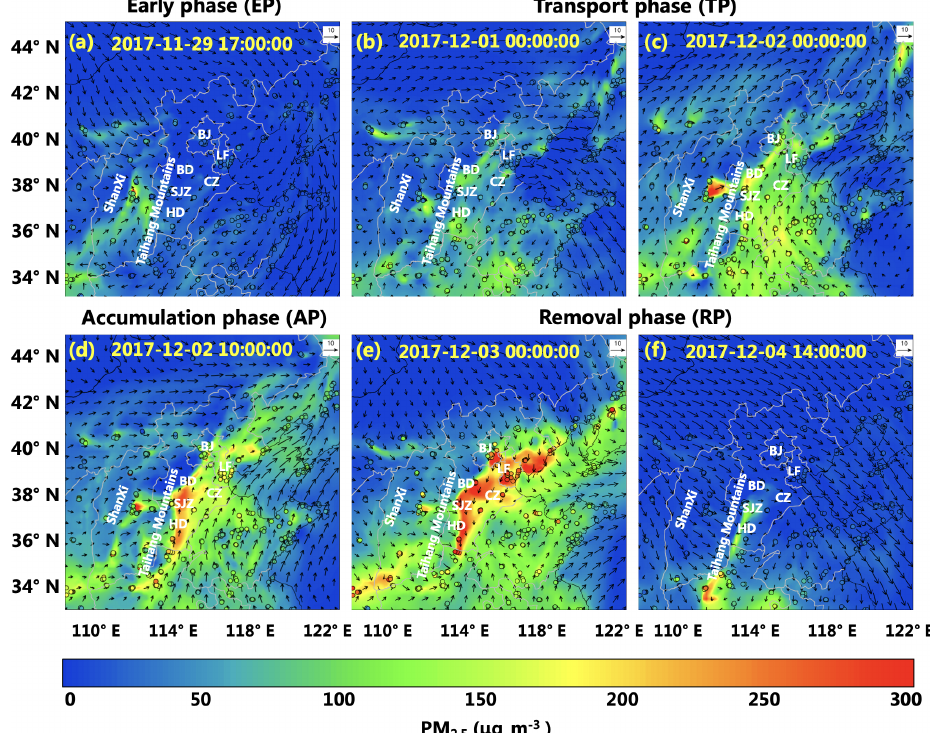
Figure 5. Spatial distribution of PM 2 . 5 in the surface layer during different phases after assimilation. The black arrows indicate the wind direction. The circles represent the in situ surface